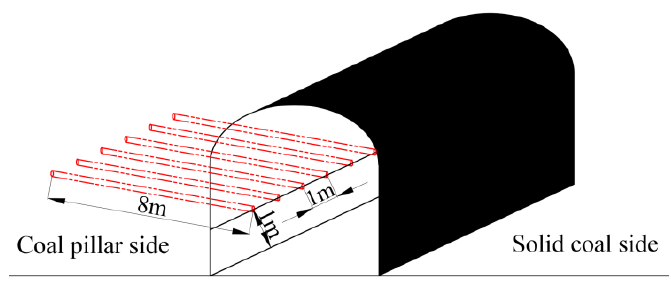
Figure 19. Drill hole layout plan.